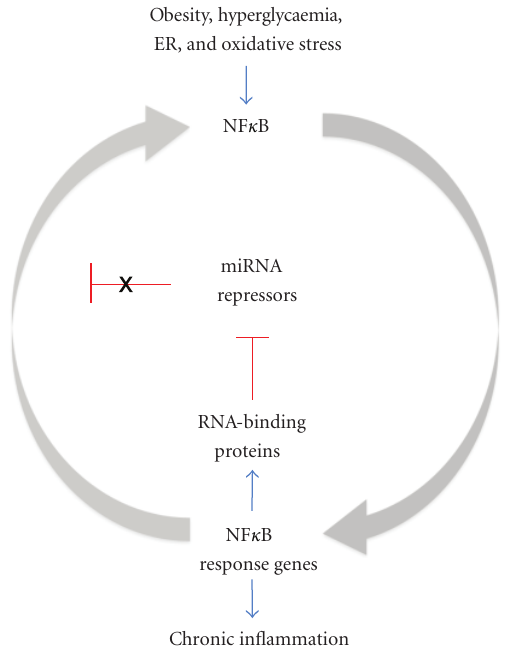
Figure 1: Diabetes-related triggers may initiate a positive feedback loop resulting in heighten responsiveness of the NF- κ B by the inhi- bition of miRNA repressors by NF- κ B-induced RNA binding